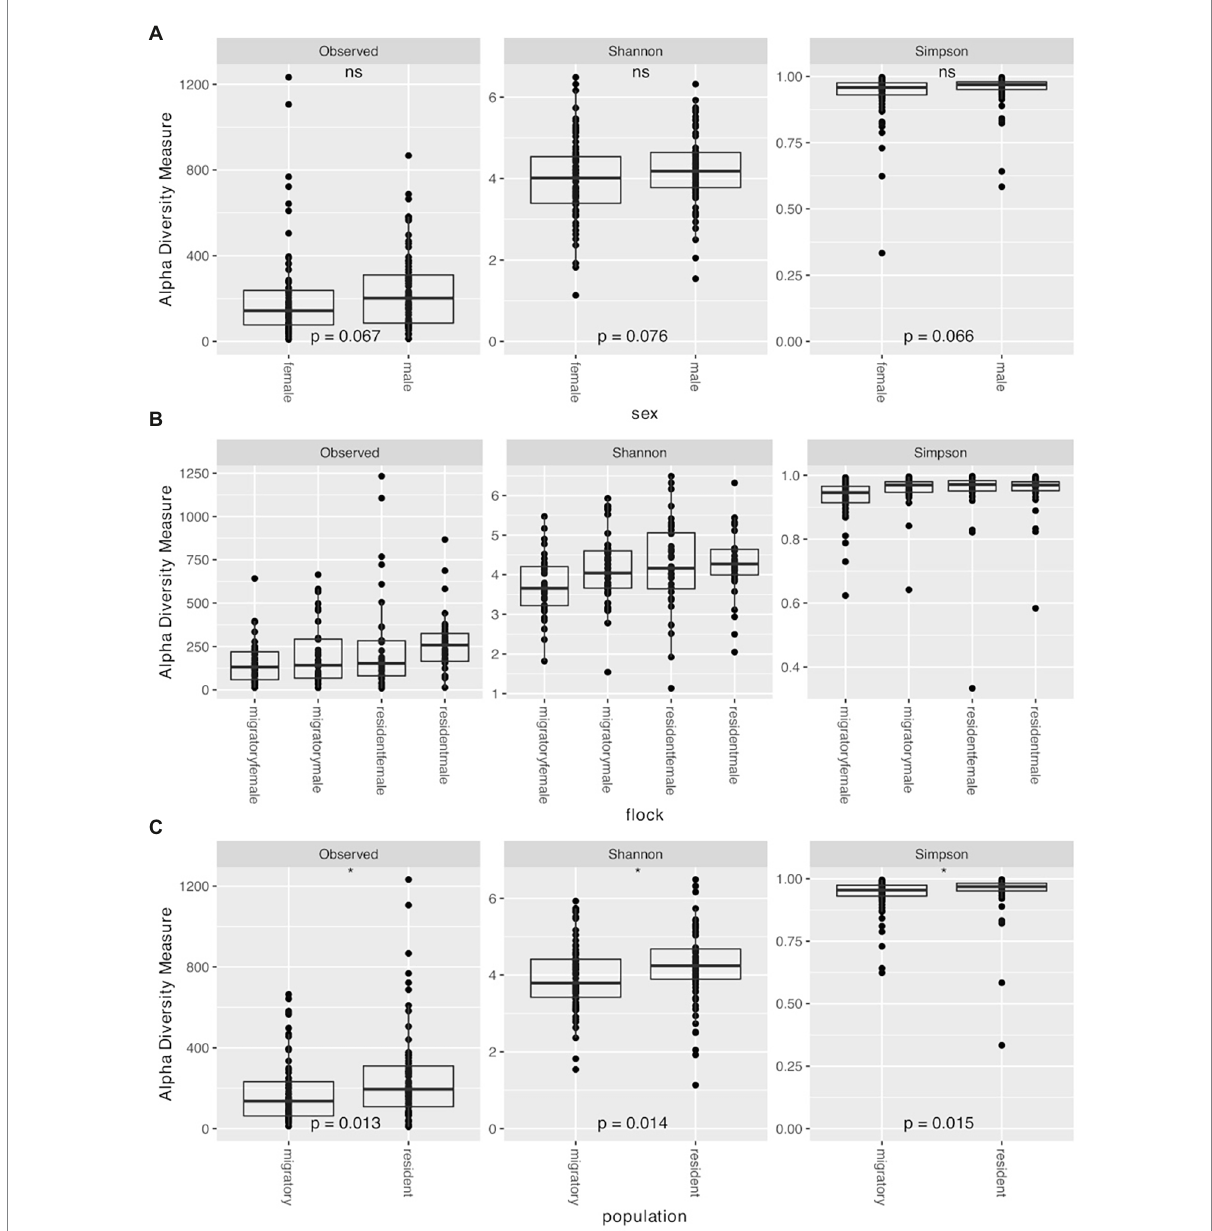
FIGURE 3 Alpha diversity measures (Observed ASVs, Shannon, and Simpson) for the juncos sampled in the experiment based on (A) sex, (B) flock group for the entire experiment (time 1 through time 5), and (C) population (sub-species). Asterisks denote significance ( p <